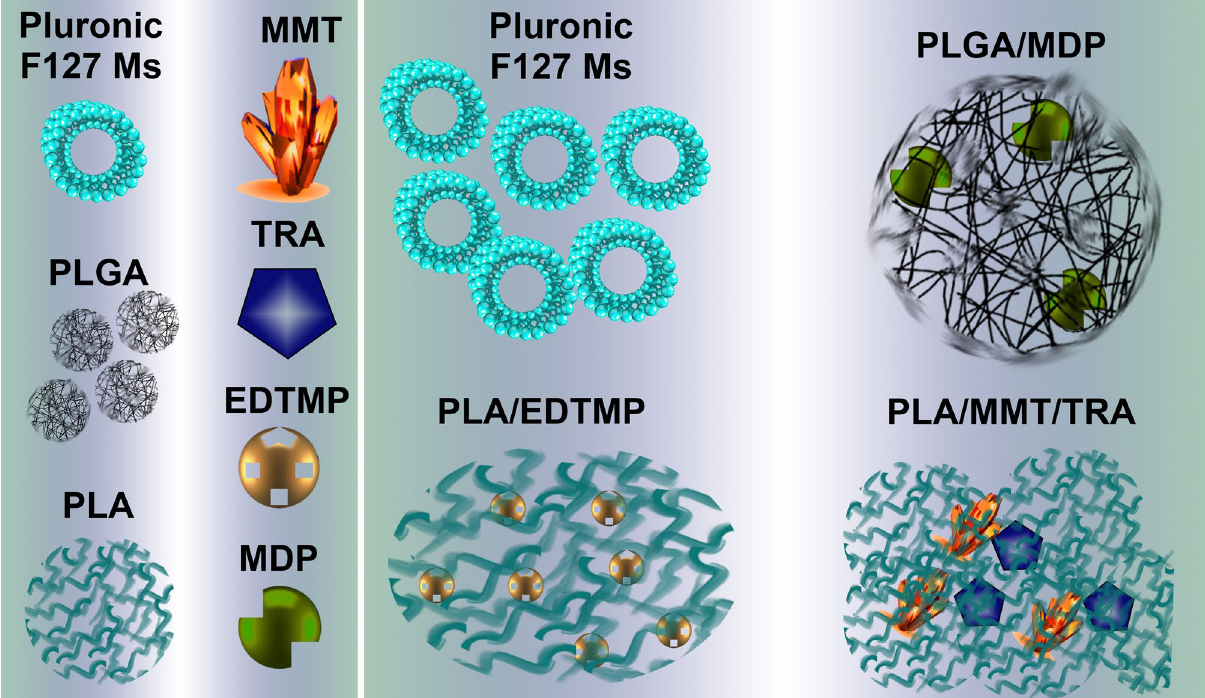
Figure 1. The schematic overview of the four nanoparticles used in the